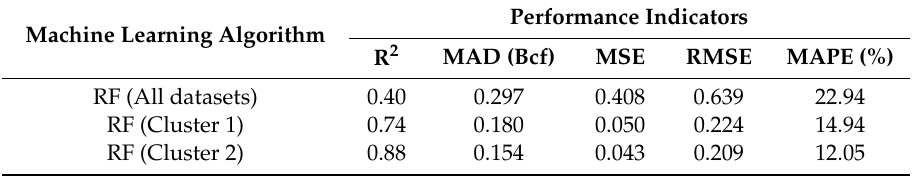
Figure 13. Boxplot of absolute percentage error for supervised learning models before and after clustering analysis. Table 5. Comparison of performance indicators of before and after clustering analysis.